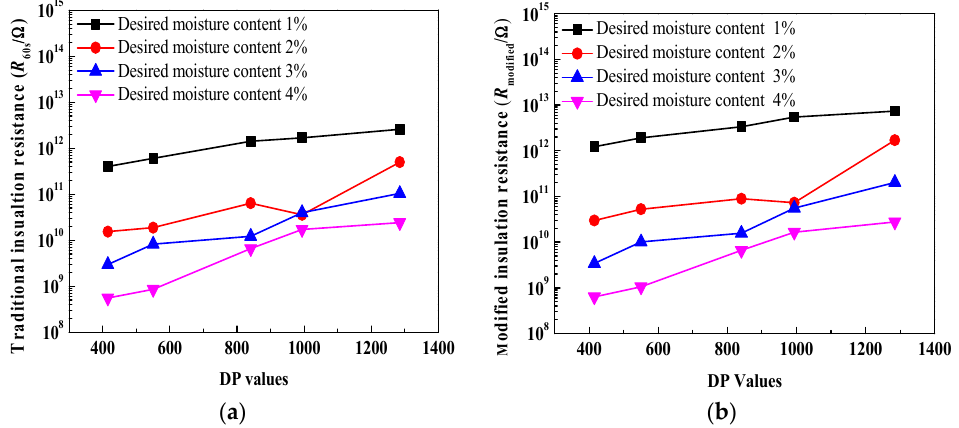
Figure 9. Comparisons of relationships between insulation resistances and DP values. ( a ) Traditional insulation resistance; ( b ) modified insulation resistance.